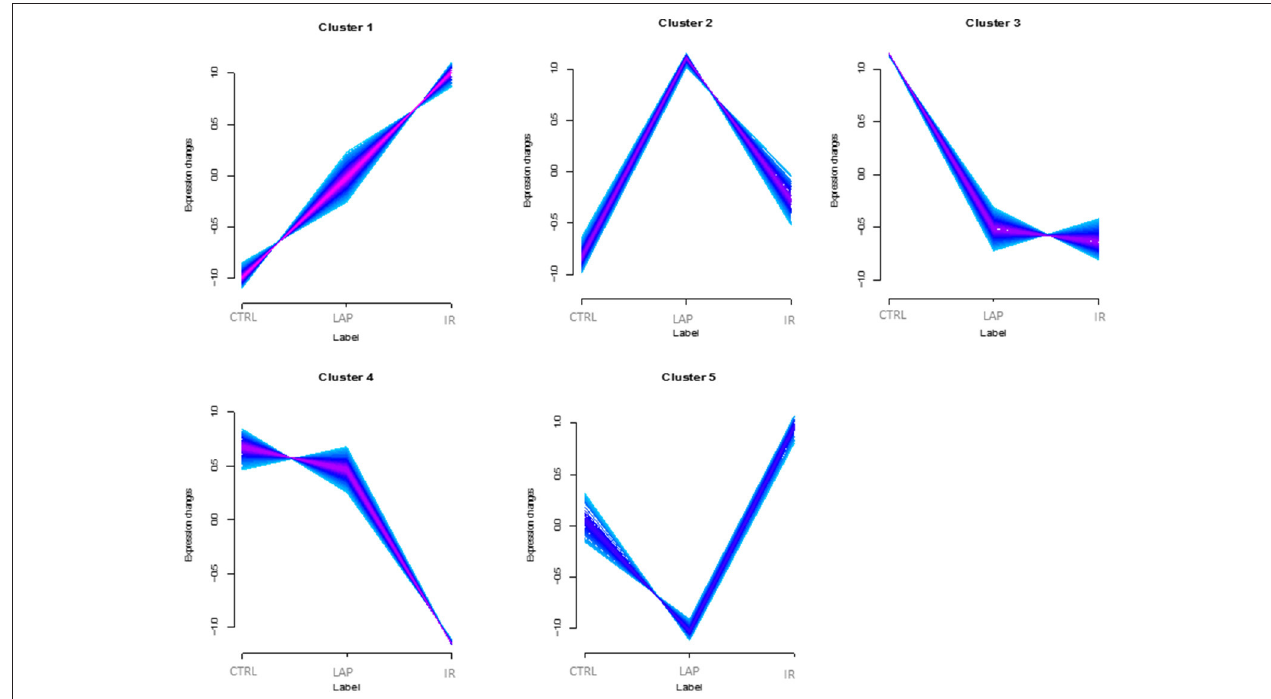
FIGURE 2 | Abundance profiles of rat neutrophils proteins. Abundance profile of the regulated proteins in control (Ctrl), laparotomy (LAP), and ischemia/reperfusion (IR) experimental groups. The x-axis shows the different conditions and y-axis represents expression change ( z -scores). The colors correspond to the membership values, representing the degree of how much a protein belongs to the nearest cluster.